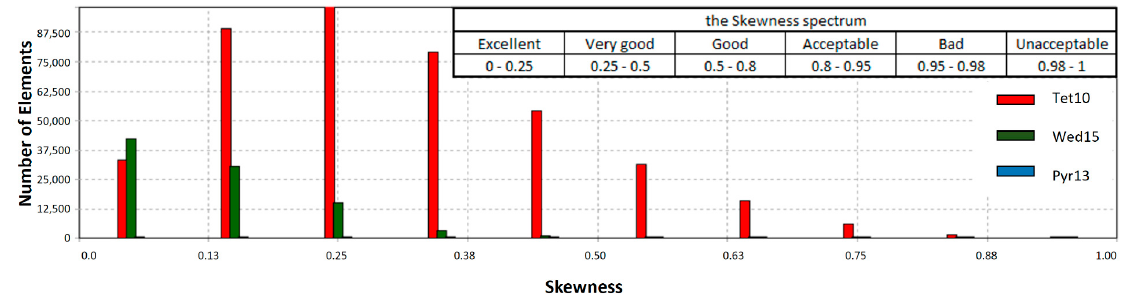
Figure 4. Mesh quality according to skewness.